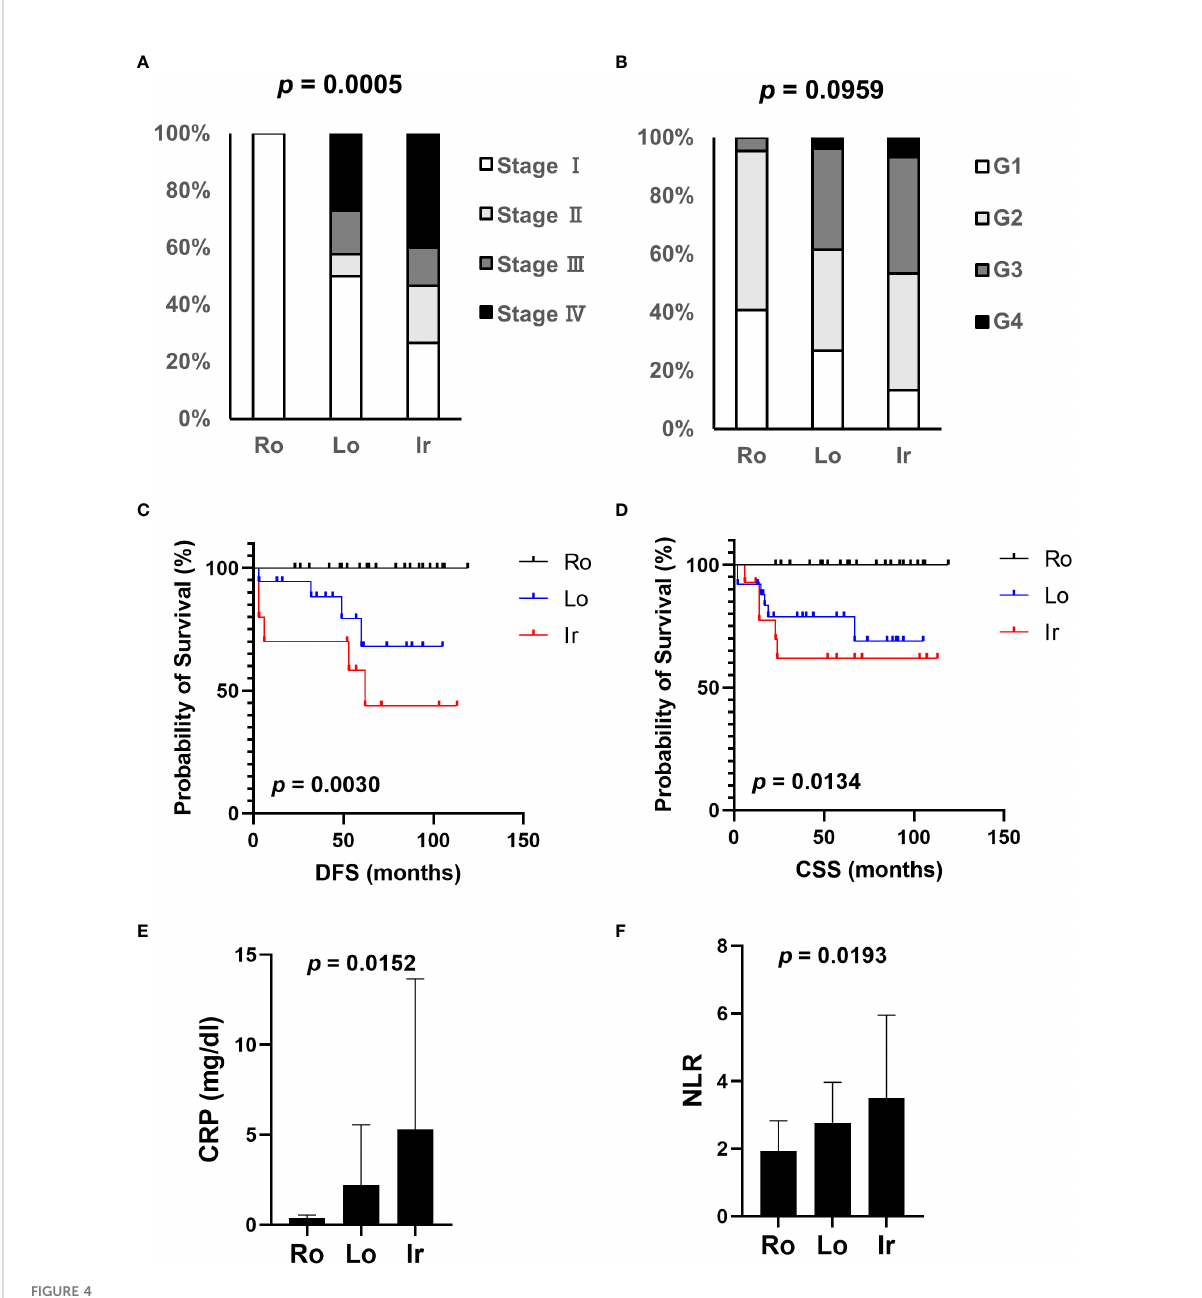
FIGURE 4 Association of clinical parameters and RM at our institution. The association between clinical parameters and RM was evaluated using data from patients with ccRCC who received radical, cytoreductive, or partial nephrectomy at our institution. (A) The relationship between each RM type and cancer stage. (B) The relationship between each RM type and cancer grade. (C) Comparison of disease-free survival (DFS) between each RM type. (D) Comparison of overall survival (OS) between each RM type. (E, F) Systemic in fl ammation-related markers, CRP level (E) , and NLR (F) were evaluated in each RM type through preoperative blood tests. Ro, round type; Lo, lobular type; Ir, irregular type; CRP, C-reactive protein; NLR, neutrophil-lymphocyte